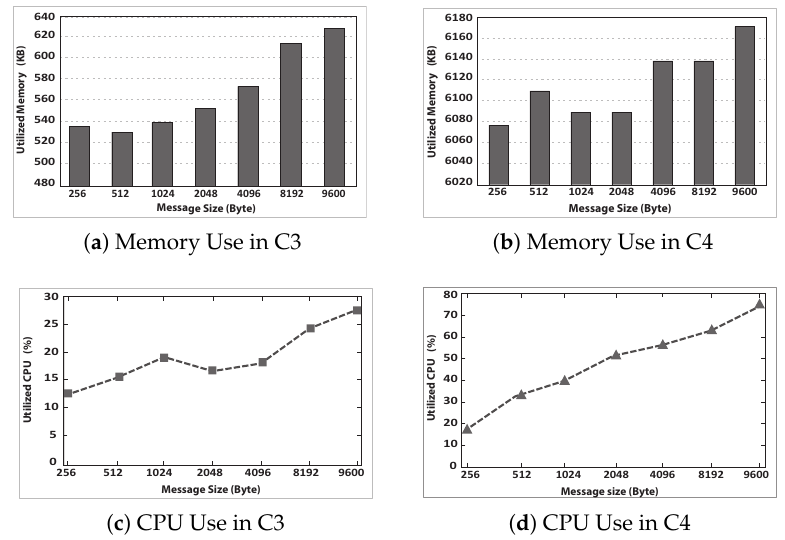
Figure 23. Resource use on Raspberry